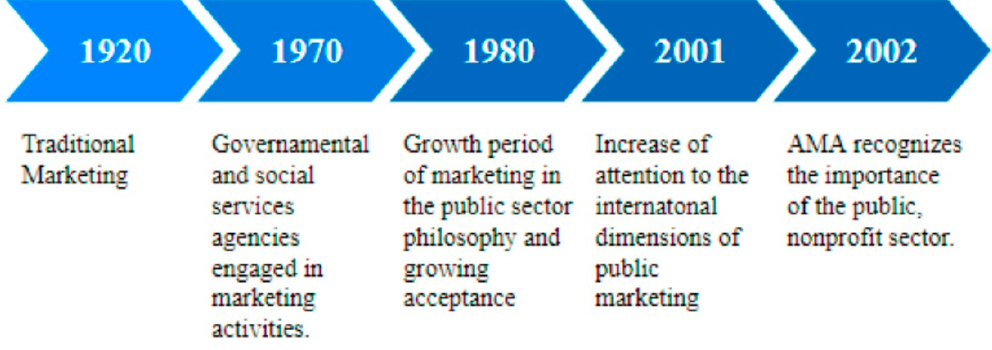
Figure 1. From traditional marketing to nonprofit marketing. Source: Adapted from Kotler and Levy (1969) and Kotler and Zaltman (1971).